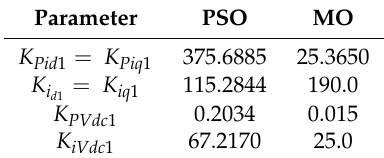
Table 2. PI parameters for rectifier station